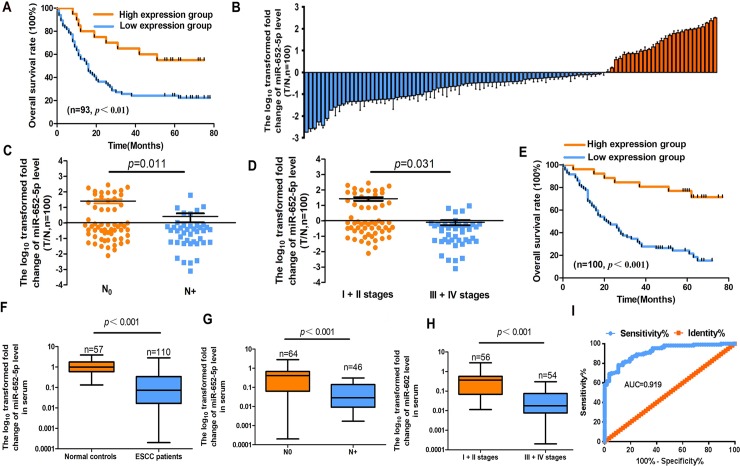
MiR-652-5p level in OSCC tissues and serum samples.(A)Kaplan–Meier OS curves of low and high expressions of miR-652-5p in OSCC patients (n = 93). (B) Quantitative analysis of miR-652-5p expression level in paired OSCC samples (n = 100) and corresponding normal tissues (n = 100). (C-D) The expression of miR-652-5p in lymph node metastasis and different stages of OSCC. (E) Kaplan-Meier curve shows the OS of OSCC patients according to miR-652-5p expression. (F) The expression level of miR-652-5p in the serum samples of OSCC patients (n = 110) and healthy subjects (n = 57). (G-H)The expression of miR-652-5p in patients with lymph node metastasis and at different stages. (I) ROC curve analysis of miR-652-5p level for the detection of OSCC.